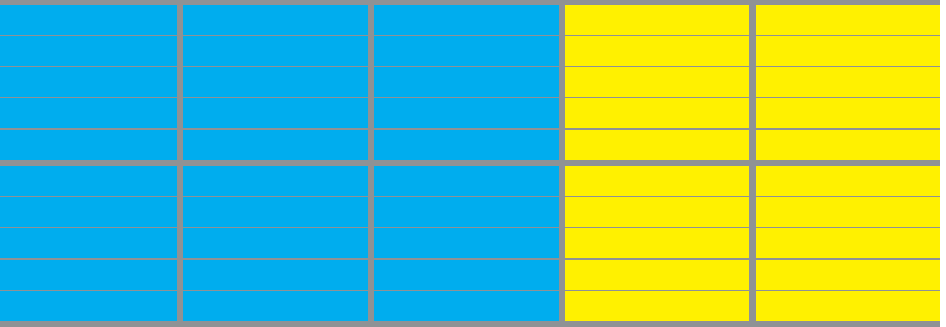
Table 2. Fifty precincts, 30 Cyan party, 20 Yellow party. Ten districts, 6 fully Cyan, 4 fully Yellow.